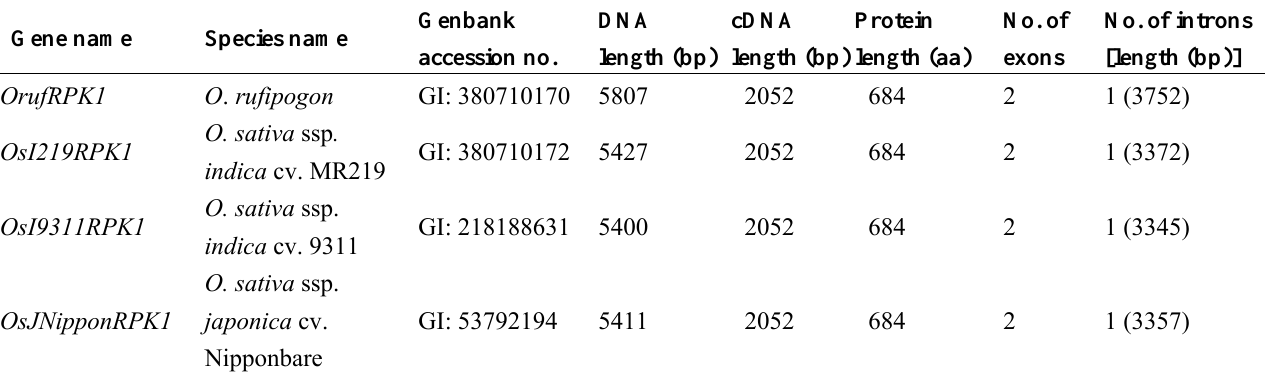
Table 1. RPK1 genes identified in the wild and cultivated